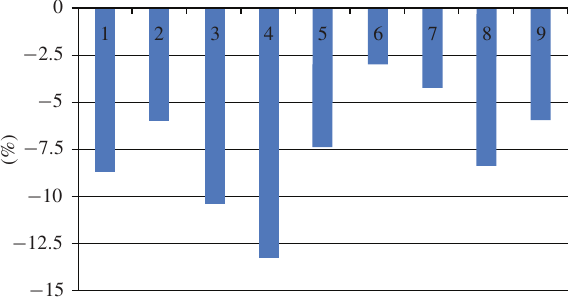
FIGURE 4: Relative differences in stalk length between W30x groups (zeroed) and G30x groups in per cent (ordinate). 1–9: experiments carried out during autumn. For further explanations see text.